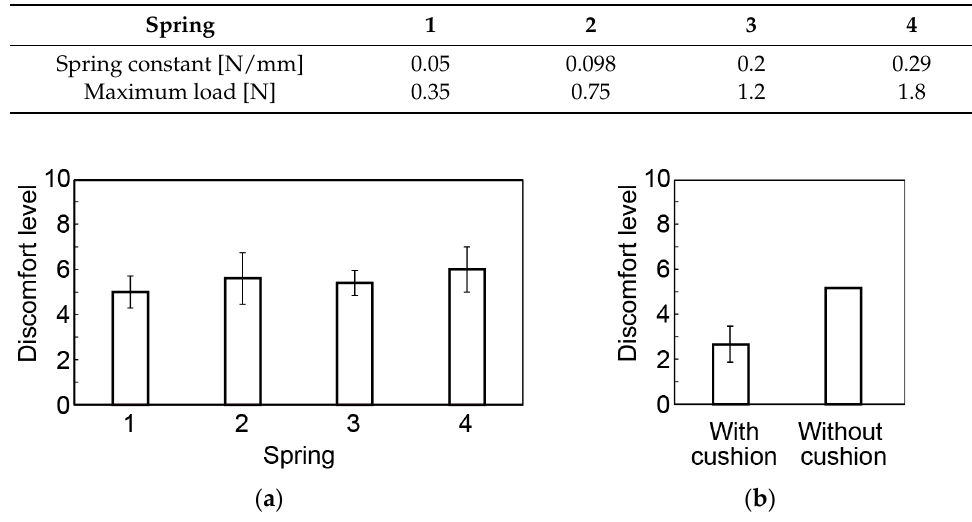
Figure 7. Comfort level for CMEs in parietal region. Effects of ( a ) spring stiffness and ( b ) cushion. Table 4. Spring constant and maximum load for tested